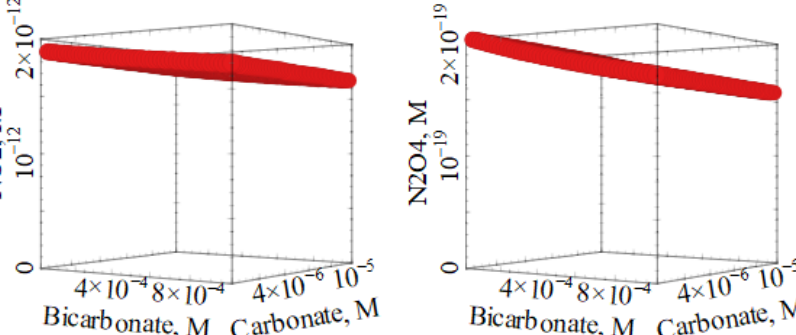
Figure 5. Effects of the concentration values of carbonate and bicarbonate on the steady-state concentrations of [ • NO 2 ] and [N 2 O 4 ]. Other conditions: 5 m water depth, 11 µ M NO 3 − , 0.85 µM NO 2 − , 1 mg C L − 1 DOC, and 22 W m − 2 sunlight UV irradiance, which is equivalent to fair weather, 45°N lat- itude 15 July, at 9 a.m. or 3 p.m.